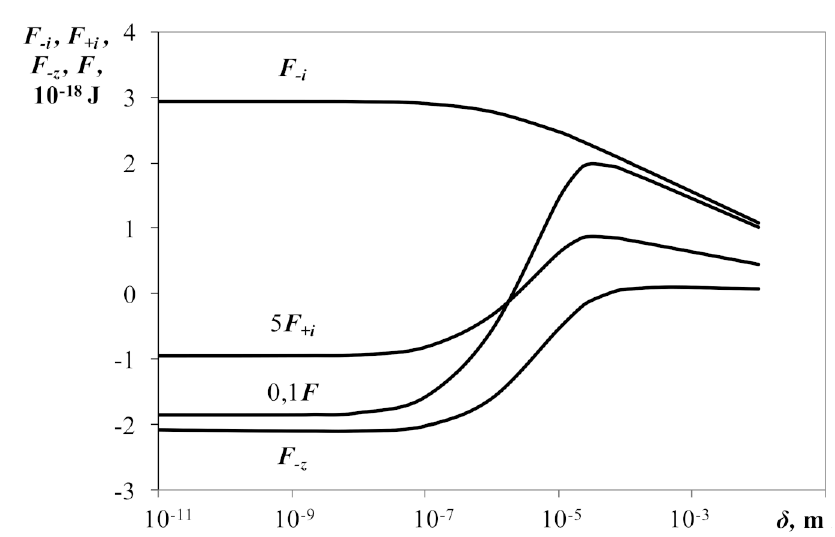
Figure 2. Free energies of charged droplet F − z , positive ion F +i , negative ion F − i and free energy of all charge carriers F subject to the distance between surfaces of the nearest droplets δ . T − i = 5000 K, T − z = T +i = 300 K, Z = 100, R − z = 10 − 6 m, R -i = R +i = 10 − 10 m, χ = 0.01.